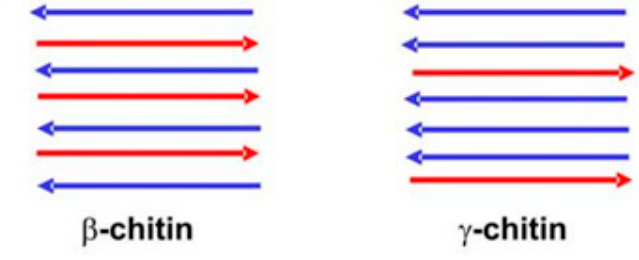
Figure 3. Polymorphic structures of chitin.